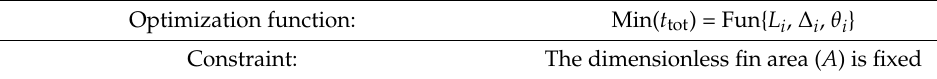
Table 2. Description of the optimization problem.